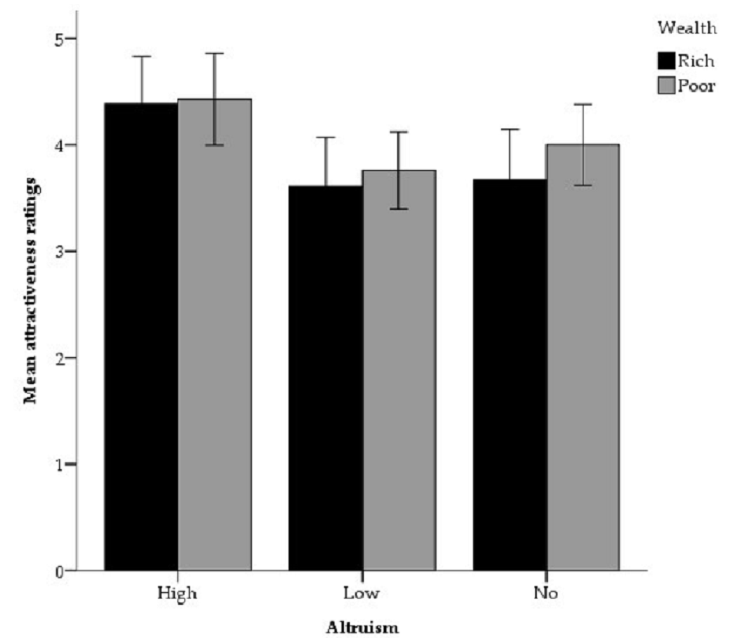
Figure 1. Mean attractiveness ratings in the high-cost, low-cost, and no altruism conditions when the actor was described as rich compared to when he was described as poor (error bars represent 95% confidence intervals).